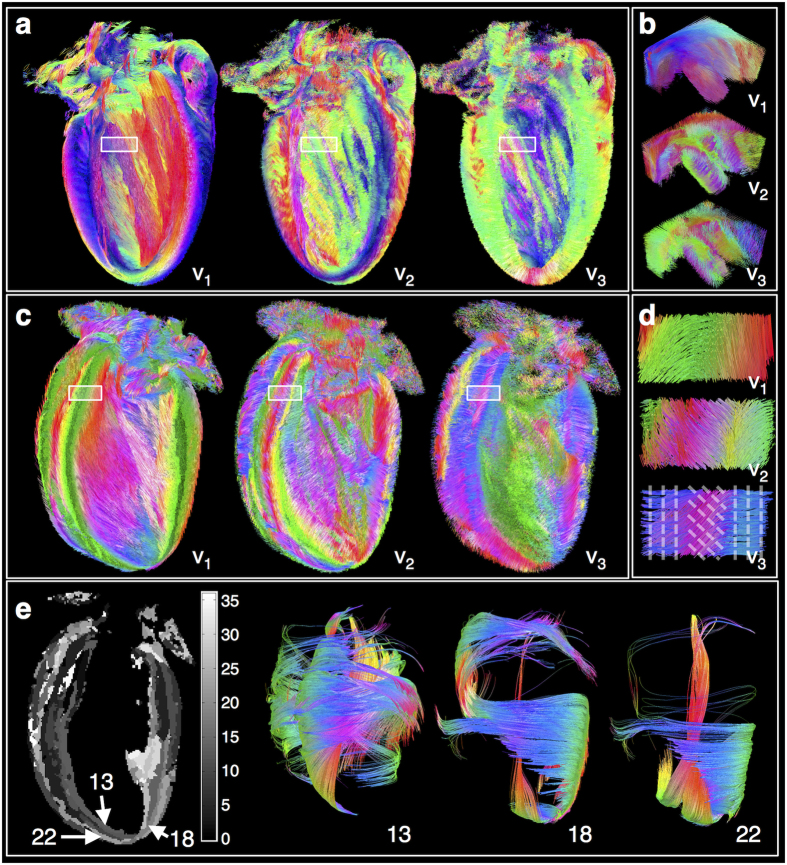
Tracking and segmentation of myocardial cell and sheetlet structures.Tracks were reconstructed based on v1, v2 and v3 and colour-coded by orientation: apico-basal (red), anterior-posterior (green) and lateral-septal (blue). (a) Digitally bisected heart viewed from the LV septal wall. (b) Magnified isometric view of tracks in a 4 × 3.5 × 2 mm section in the papillary muscles. v1 tracks reveal that cells are aligned along the length of the papillaries, while v2 and v3 tracks are indicative of a concentric sheetlet arrangment. (c) Digitally bisected heart viewed from the LV anterior wall. (d) Magnified view of tracks in a 2.5 × 1 × 1 mm section in the LV septal wall. The transmural variation in dominant cell orientation can be seen from the v1 tracks. This relatively gradual variation in cell orientation belies sharp discontinuities in sheetlet orientation as seen in v3 tracks. Dashed lines overlaid on v3 tracks approximate the underlying sheetlet laminae. (e) Map of clusters based on orientation of v3; v1 tracks intersecting sample clusters 13, 18 and 22 illustrates distinct cell alignment in discretised sheetlet structures.